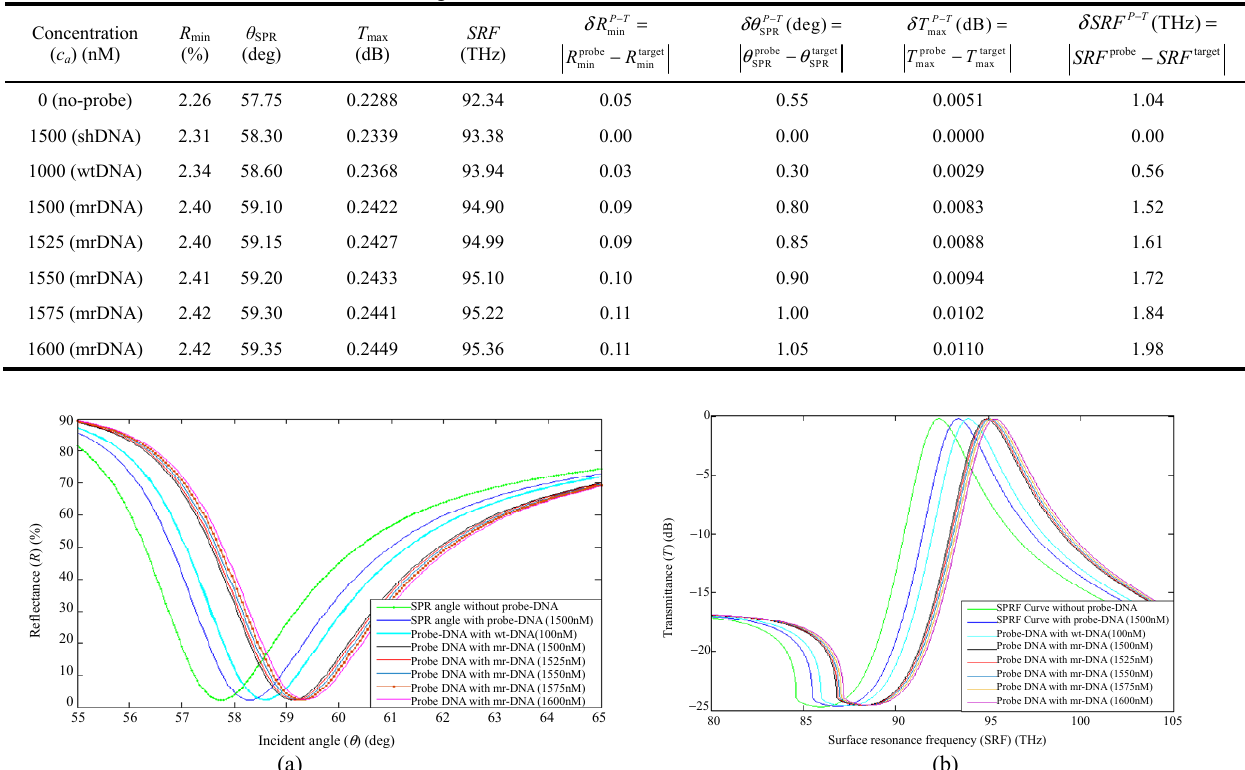
Table 4. Data of change of detecting attributors ( δ R min , δθ SPR , δ T max , and δ SRF ) for introducing different concentrated target wtDNAs or mrDNAs of BRCA1 and BRCA2 genes.